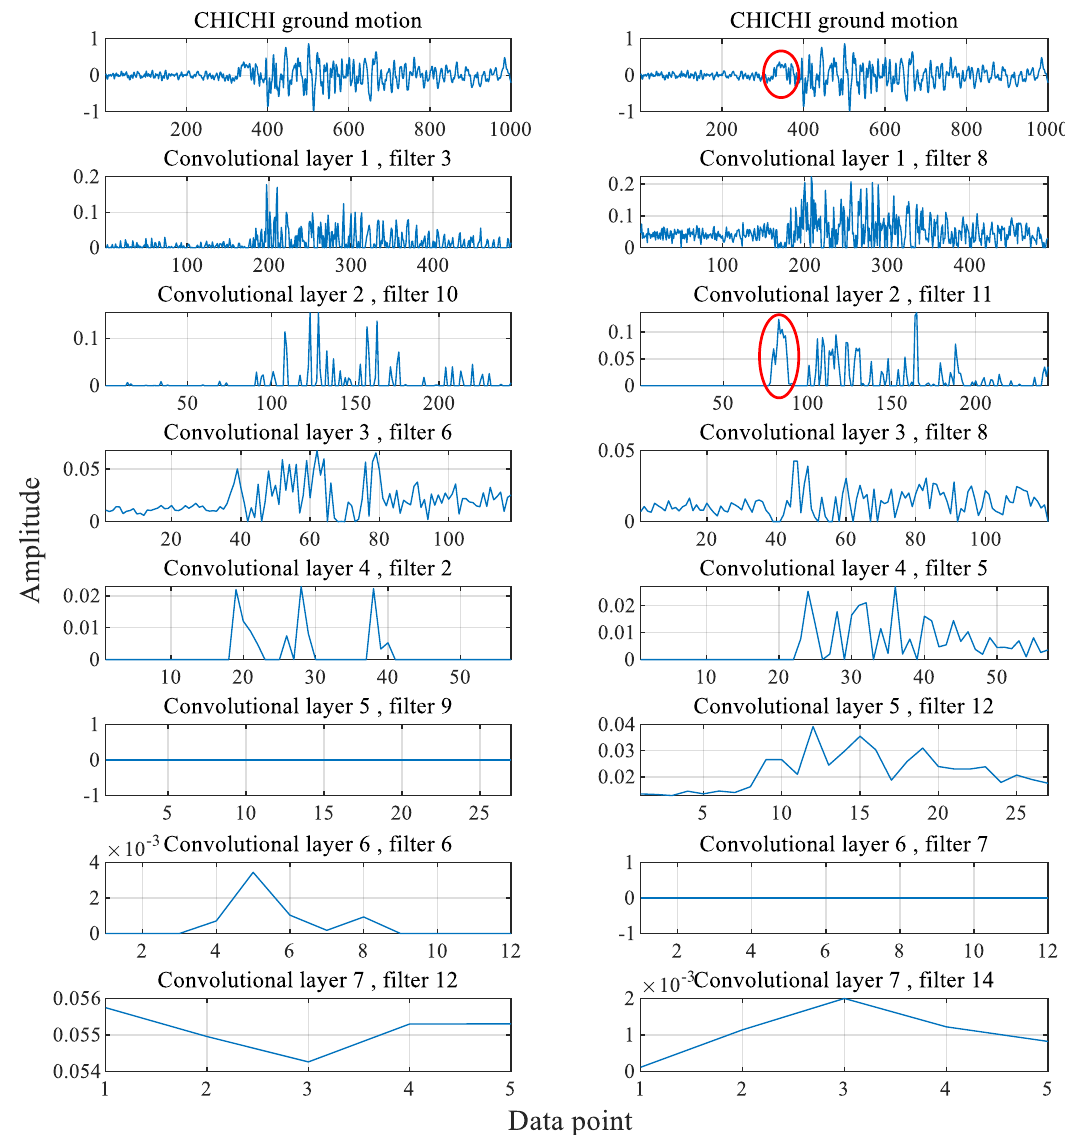
Figure 16. Features extracted from di ff erent convolutional